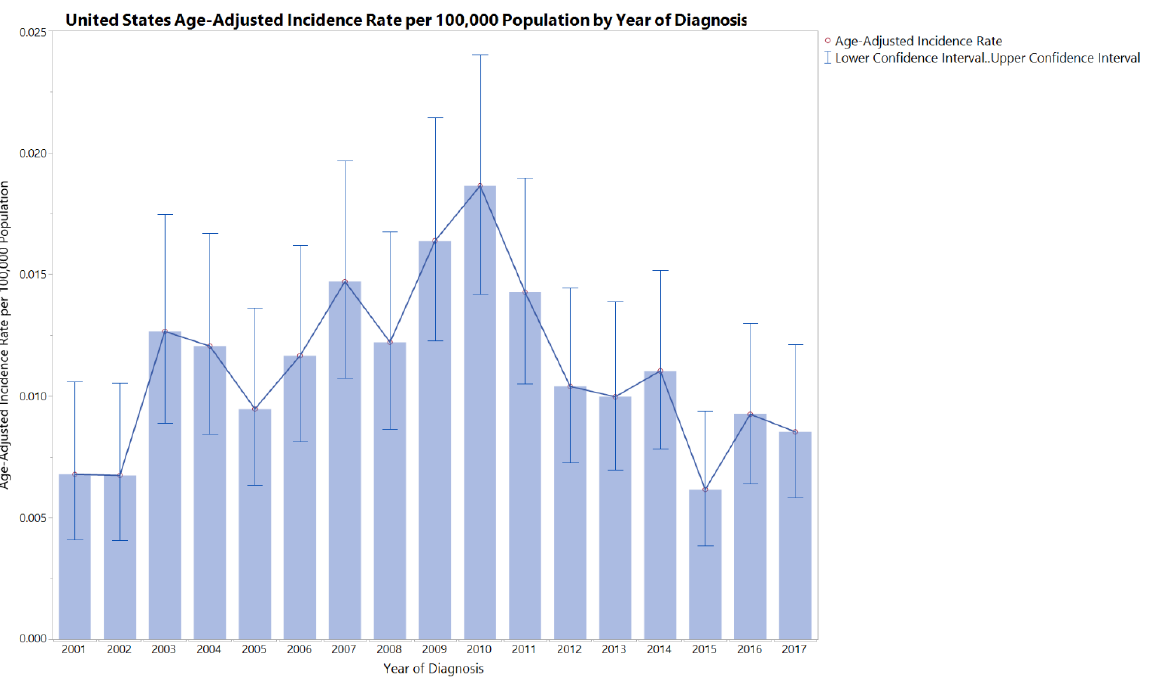
Figure 2. United States Temporal Trend over the time between 2001 and 2017 shows the age-adjusted incidence rate per 100,000 for each year of patients diagnosed with mixed pancreatic endocrine and exocrine tumor, malignant. The error bars are between the lower and the upper 95% confidence interval of the age-adjusted incidence rate.